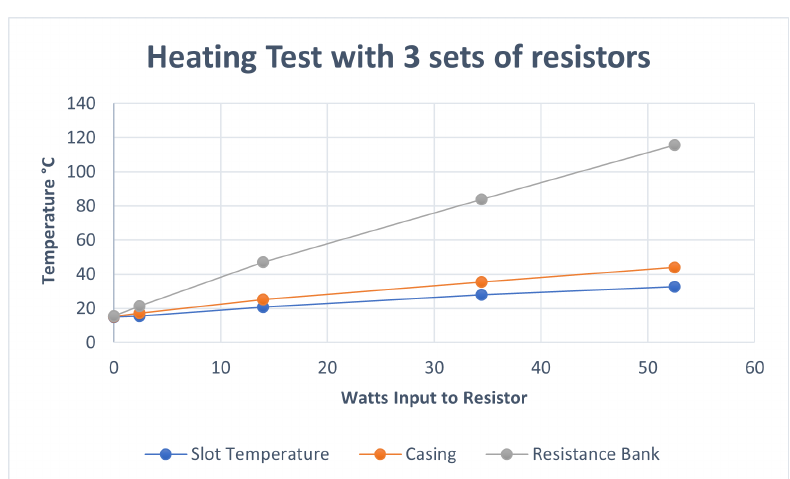
Figure 8. The graphed results of the heating with the